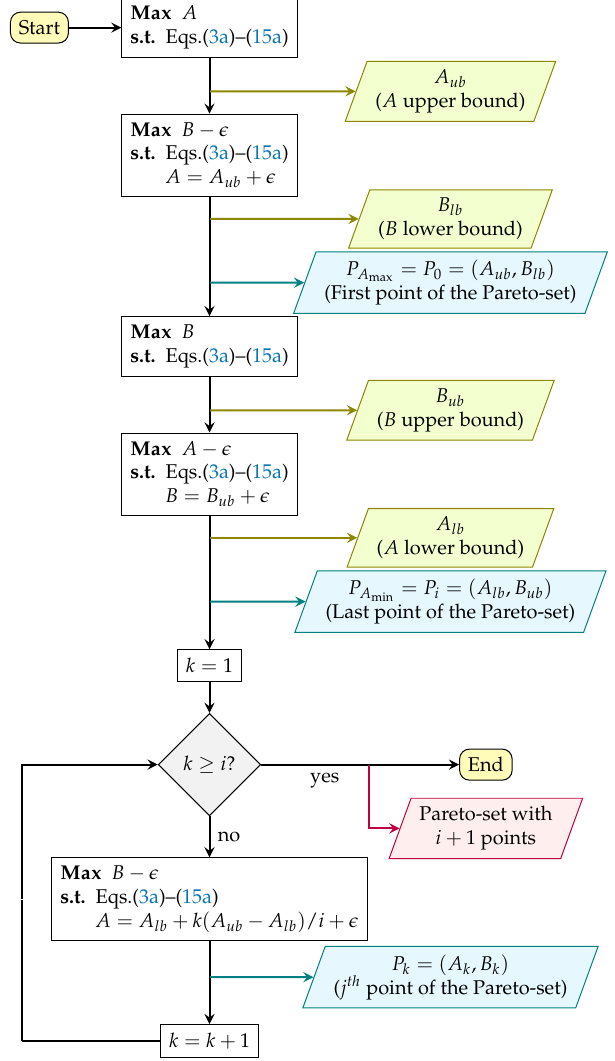
Figure 2. Representative flowchart of the (cid:101) -constrained solution